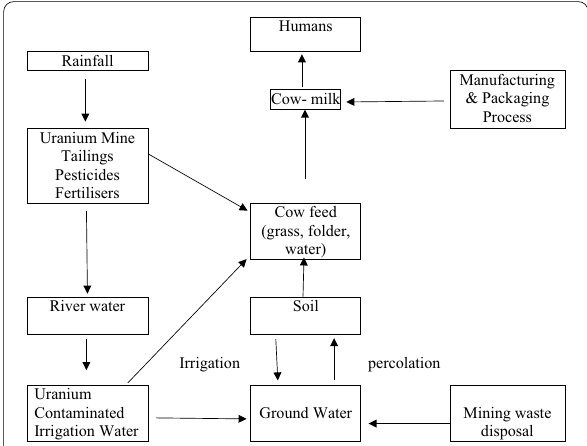
Fig. 1 Possible food chain pathways through which milk may be contaminated by U and eventually humans exposed to U by consuming milk (modified after Muhib et al.